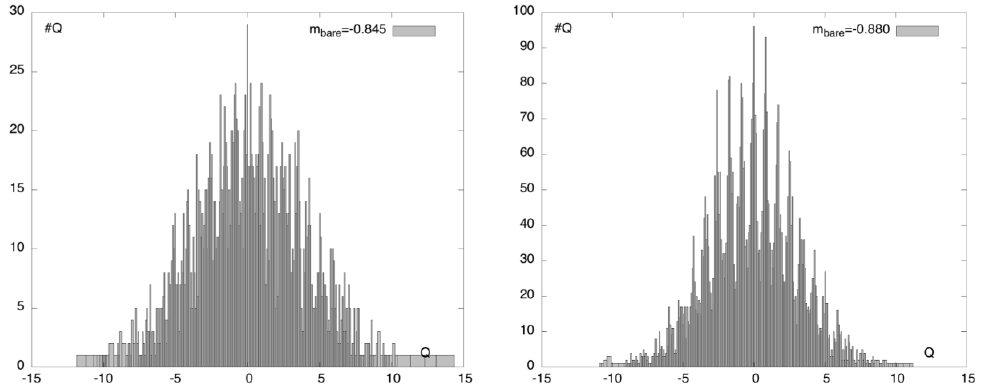
Figure 9 . The left panels contain histograms of topological charge of all con(cid:12)gurations for m 0 = (cid:0) 0 : 845 and m 0 = (cid:0) 0 : 880 at gradient (cid:13)ow time t (cid:25) t 0 .